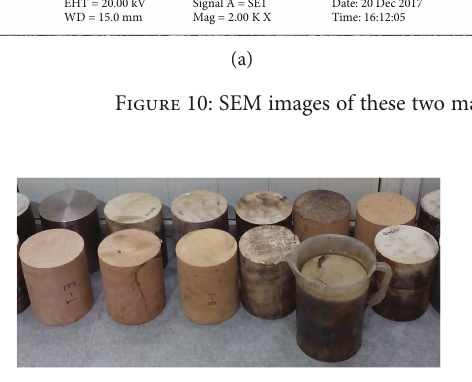
Figure 11: Testing specimens of physical simulation